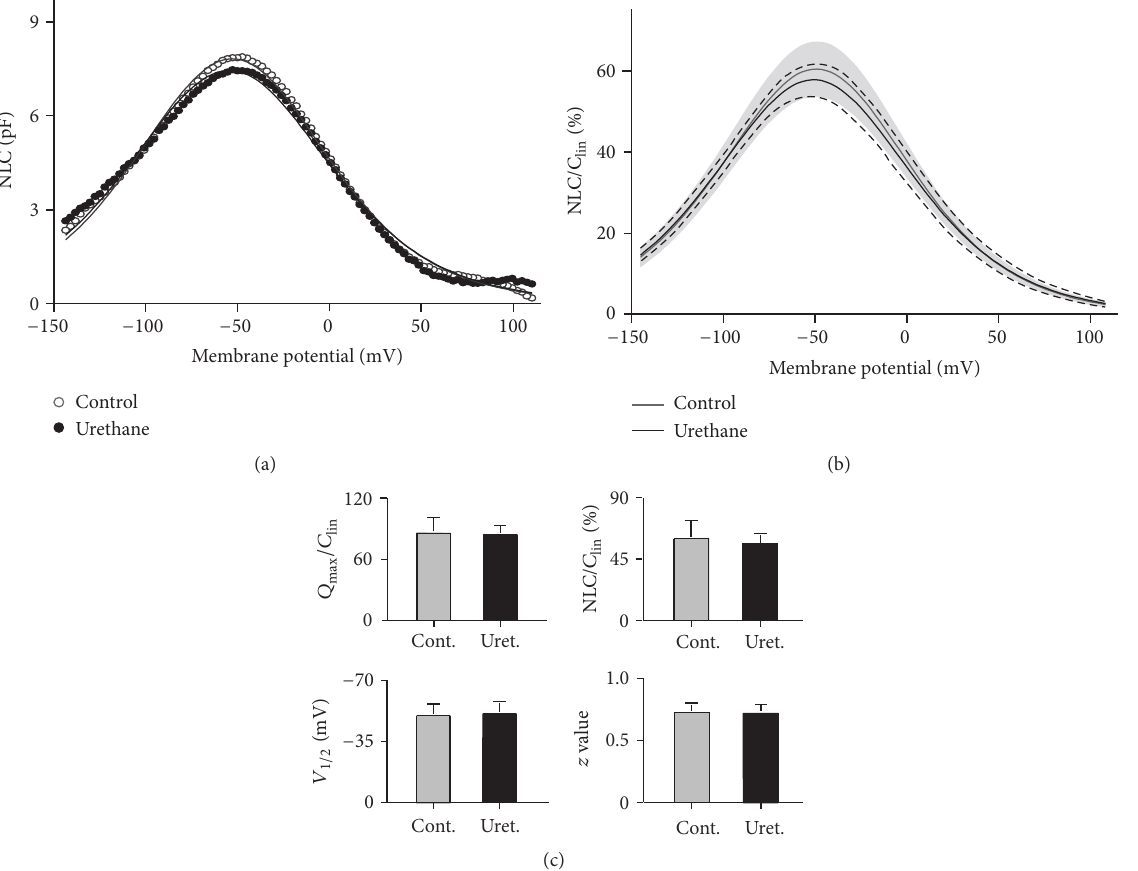
Figure 5: The effects of urethane on the NLC measured from OHCs. (a) The NLC obtained from a representative OHC before (control, open circles) and during (urethane, filled circles) 100mM urethane application. The capacitance-voltage responses were fitted to the Boltzmann function (shown as the gray and black lines). 𝐶 lin was subtracted from the NLC. pF, picofarads. (b) Pooled data of the NLCs recorded from 10 OHCs. The NLCs were normalized to the corresponding 𝐶 lin , and the curves were plotted as the mean NLC ± SD. The SD around the mean is indicated by the shaded region for the control and by dashed lines for urethane treatment. (c) Four parameters derived from the curve fit to the Boltzmann function. The data are expressed as the means and the SDs; 𝑁 = 10 . No significant difference was detected between the cases before and during urethane application (Student’s 𝑡 -test, 𝑝 > 0.05